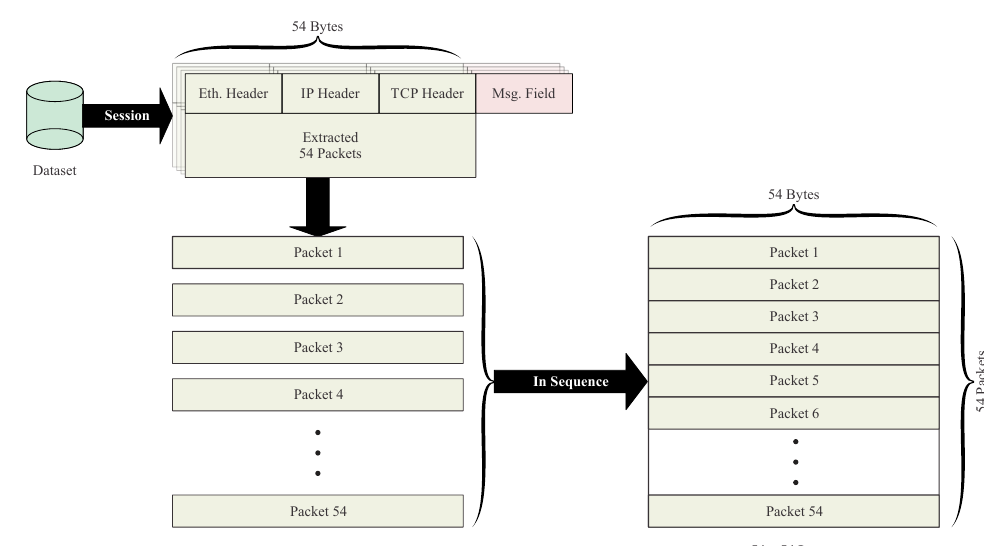
Figure 1. Procedure of the proposed image embedding, i.e., transforming packets to an image.